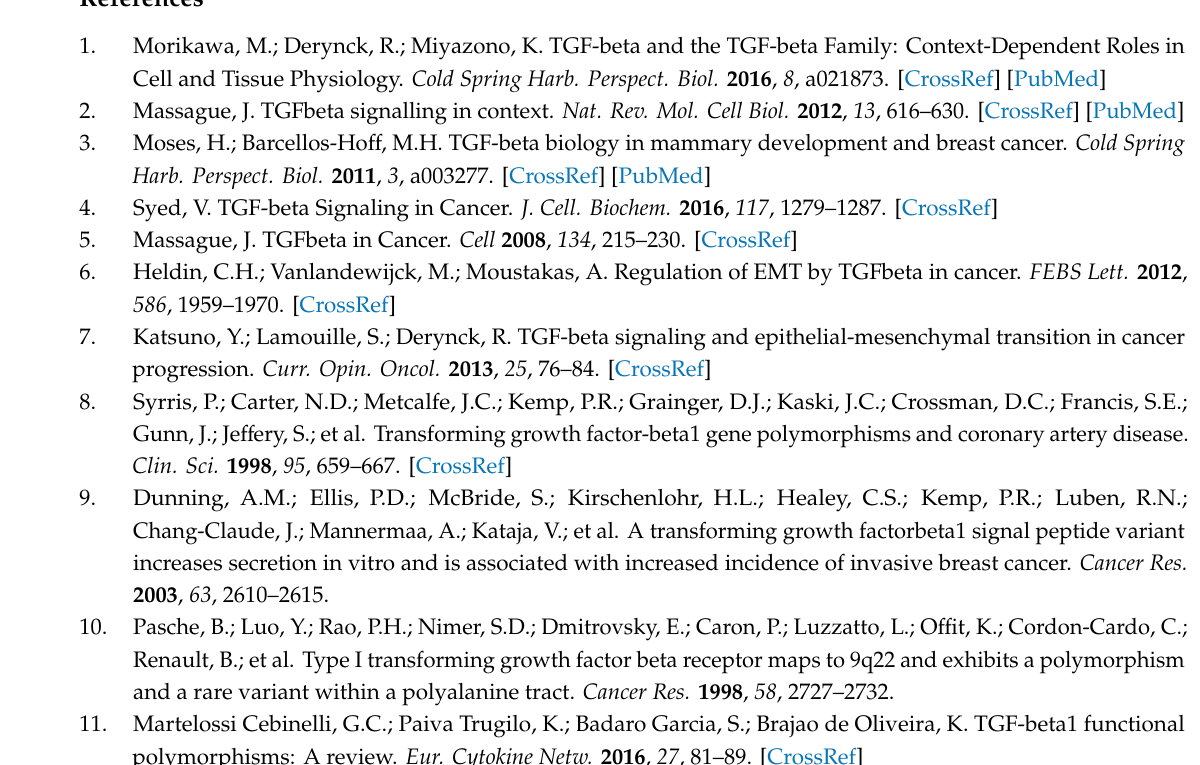
Figure S1: PRISMA flowchart: Search, screening and selection of eligible studies included in meta-analysis for evaluating the association of TGF- β polymorphisms with breast cancer risk. Figure S2: Funnel plot: Assessment of publication bias using Begg’s funnel plot and Egger’s regression test. Asymmetric Begg’s funnel plot was made symmetric using “Trim and Fill” method. Figure S3: Forest plot: Analyzing the influence of detection methods on association of TGF- β 1 29T > C polymorphism with breast cancer risk. Studies were separated based on the methods used for the detection of polymorphism [(A) PCR-RFLP and (B) Taqman] and were analyzed individually. Figure S4: Forest plot: Studies were separated based on the methods used for the detection of TGF- β 1 -509 C / T polymorphism [(A) PCR-RFLP and (B) Taqman] and were analyzed individually to assess its association with increased risk of breast cancer. Figure S5: Sensitivity analysis: One individual study of TGF- β 1 29T > C was excluded each time and was analyzed to assess the e ff ect of individual study on combined OR. Figure S6: Sensitivity analysis: Each study was assessed for the potential influence on combined OR by deleting single study each time and performing the analysis for TGF- β 1 -509 C / T polymorphism. Figure S7: Sensitivity analysis of each study representing TGF- β *6A polymorphism in the meta-analysis by one study removal method. Figure S8: Trial sequence analysis of all the included studies. TSA figure for TGF β -1 29T > C overall (A), Caucasian (B), Asian (C) showed enough number of samples enrolled for the analysis except for the American (D). TSA analysis for other two SNPs TGF- β 1 -509 C / T (E) and TGF- β *6A (F) also revealed similar results. Table S1: Statistics for heterogeneity